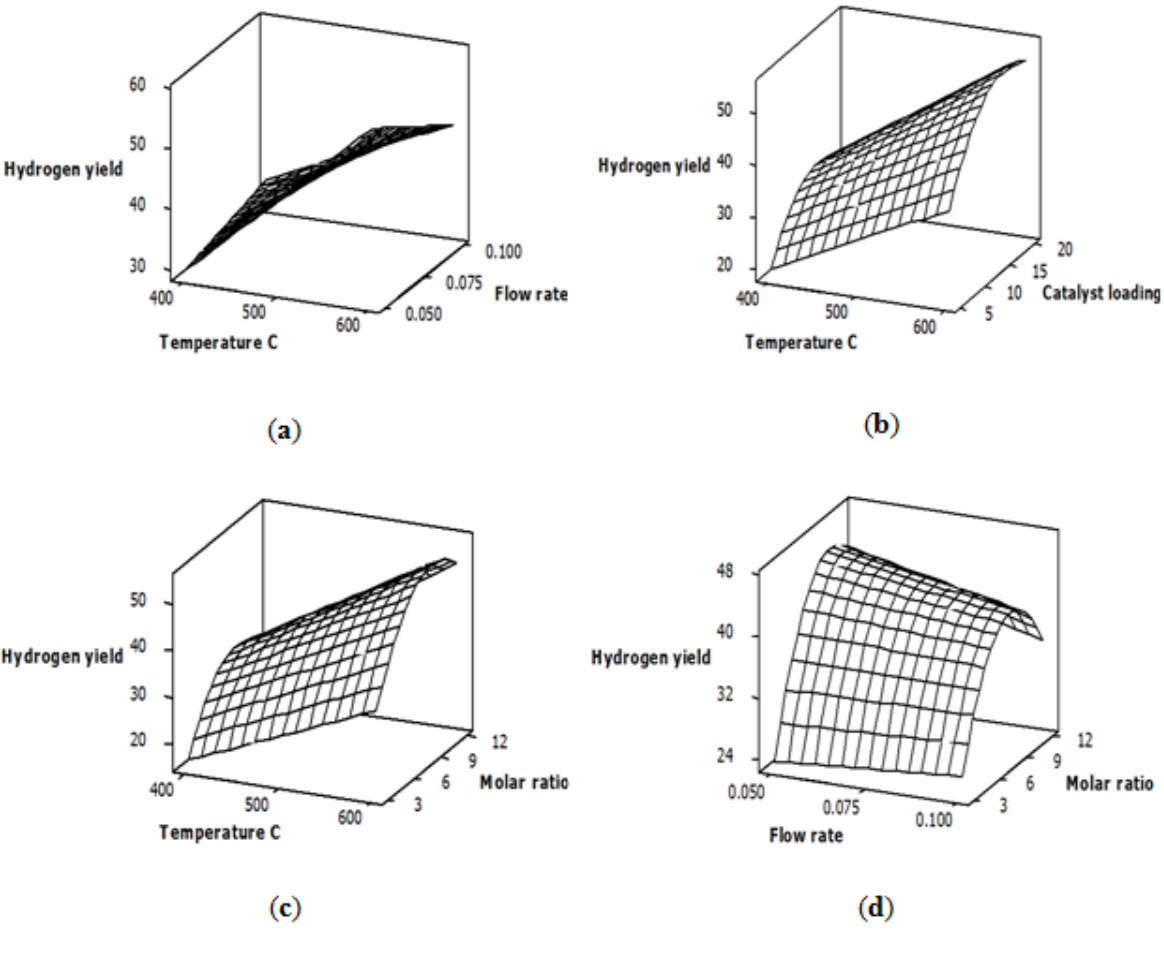
Figure 1. The interaction effects of process variables on hydrogen yield: ( a ) temperature and flow rate; ( b ) temperature and catalyst loading; ( c ) temperature and molar ratio; ( d ) flow rate and molar